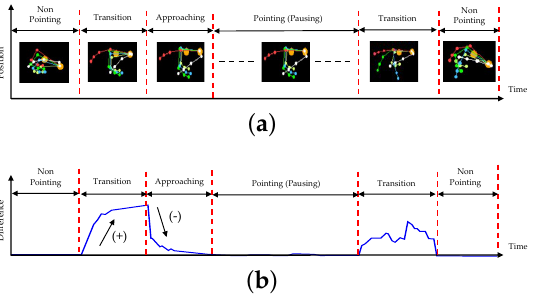
Figure 8. Pause duration and transition: ( a ) A sequence of finger joint form, ( b ) Differences of consecutive frames.